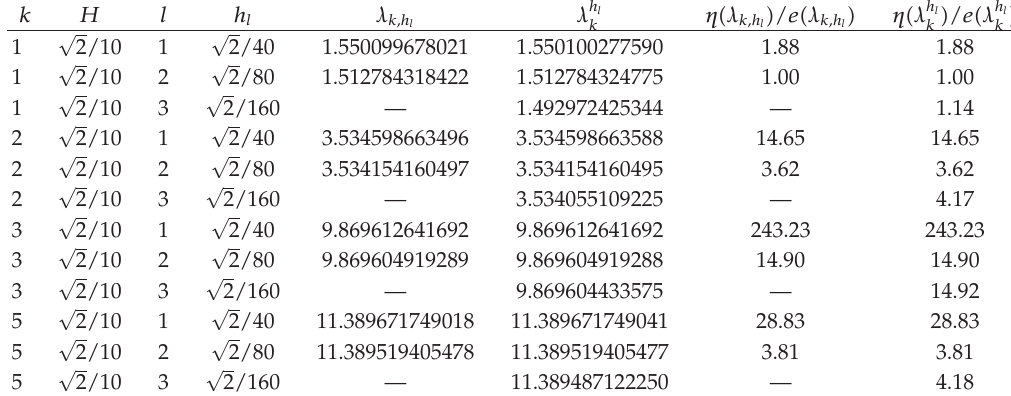
Table 3: The results on the L-shaped domain by Scheme 1 (cid:3) P 2 - P 1 element (cid:6) for the eigenvalue problem of electric field (cid:3) r (cid:8) 0 . 95 (cid:6)